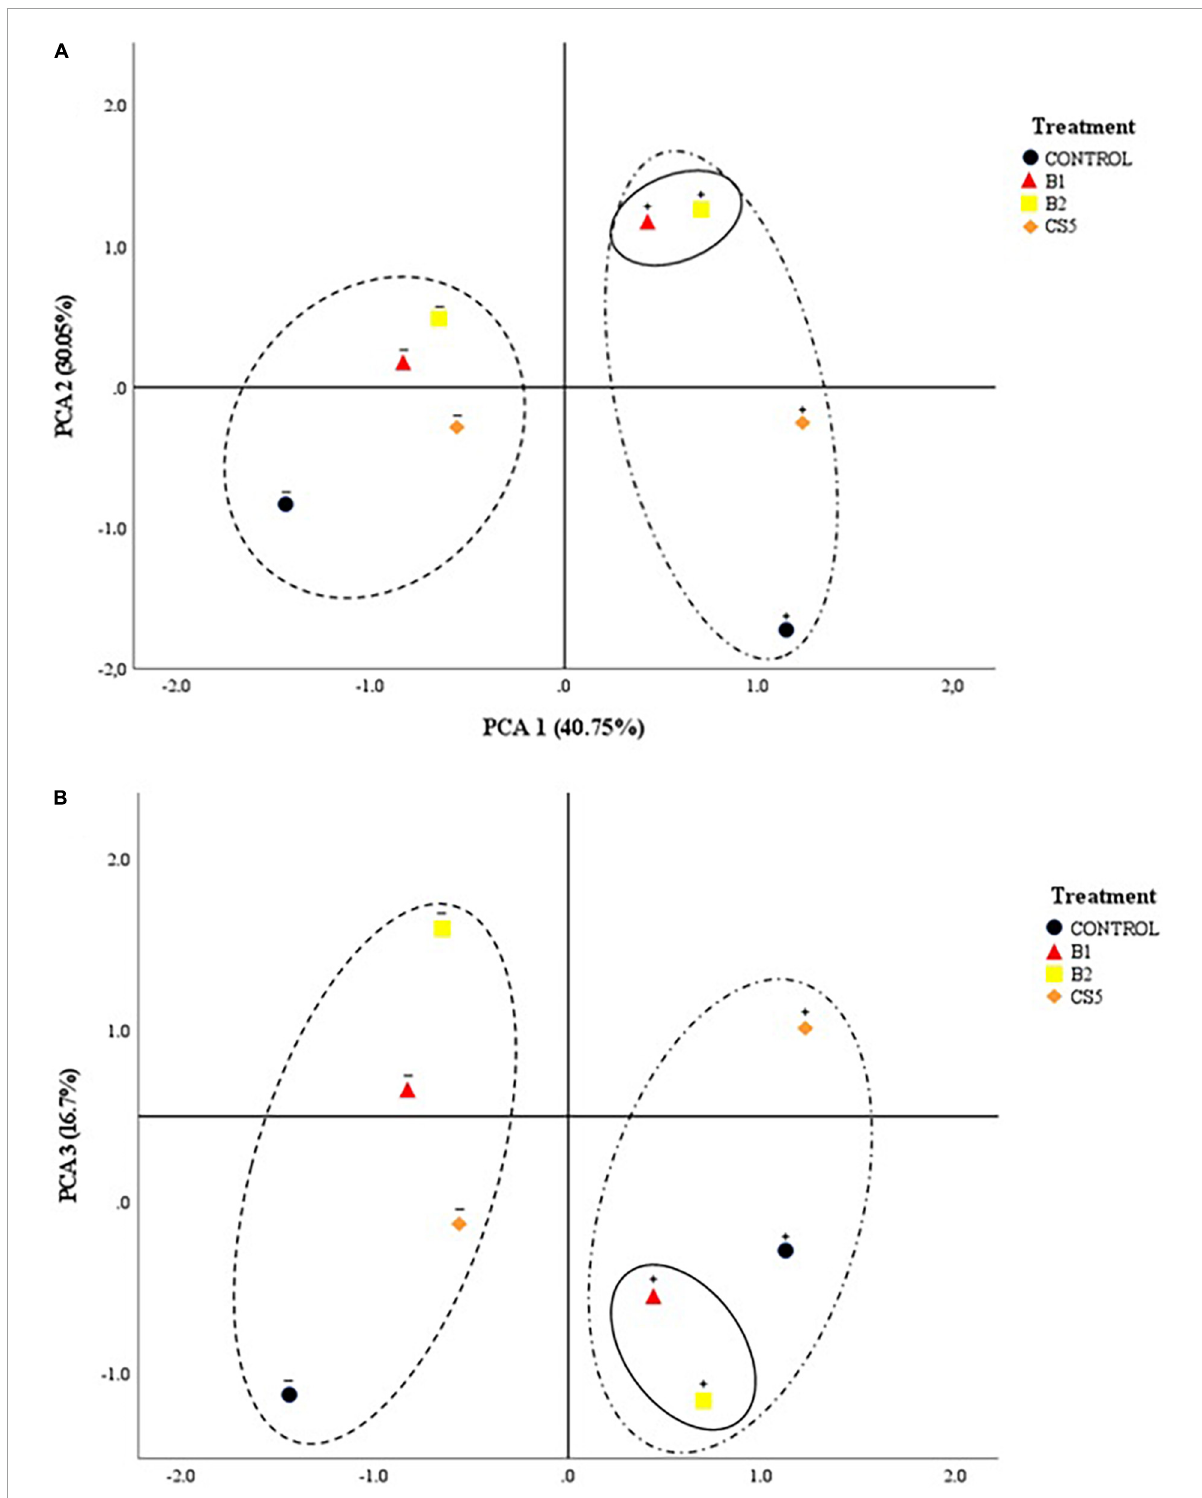
FIGURE4 2D projection of the main components: (A) PCA1 vs. PCA2 and (B) PCA1 vs. PCA3 of the biological treatment (B1, B2, and CS5). The “+” sign on the treatment refers to “soil with a high concentration of Hg”; the “–” sign above the treatment refers to “soil without